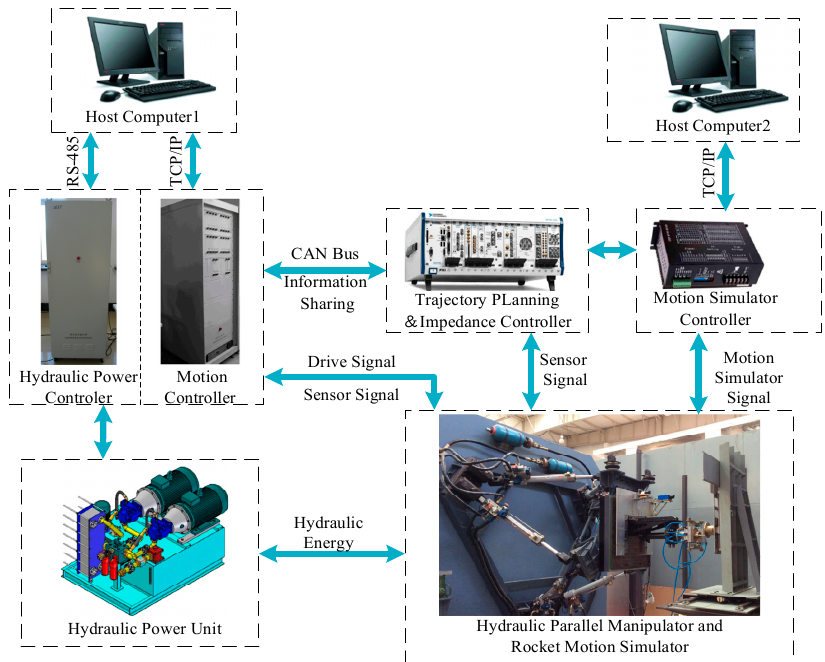
Figure 18. Experimental system